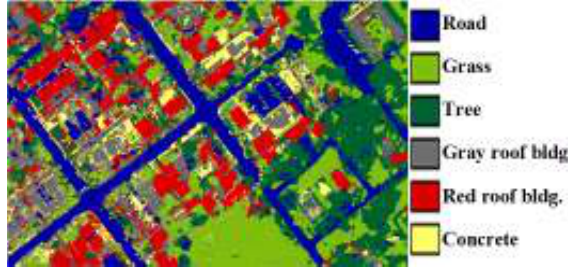
Figure 4. Results obtained for the RGB+IS combination